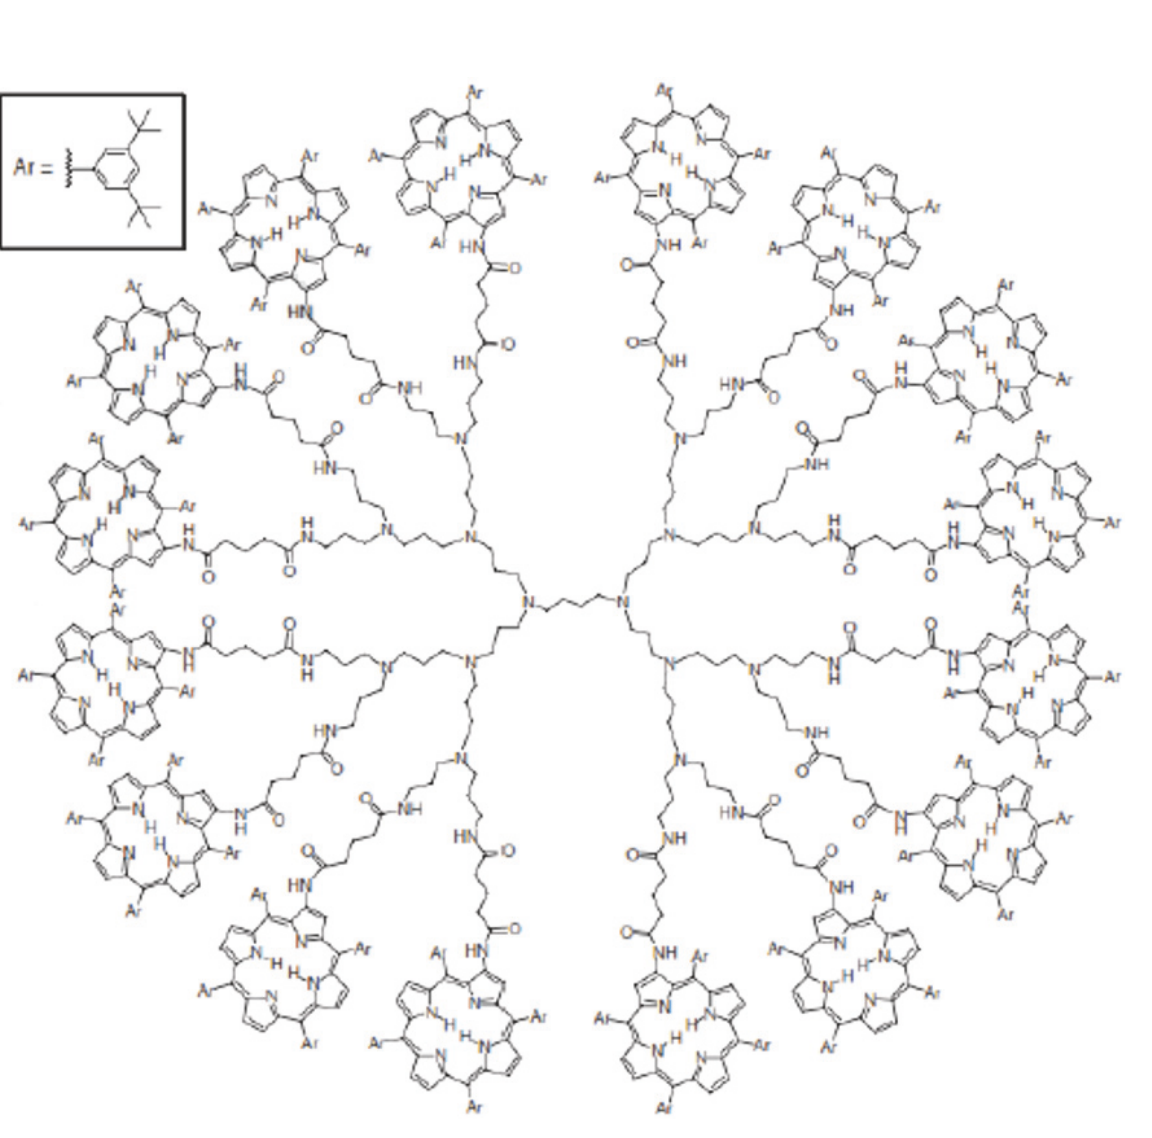
Figure 1: Porphyrin